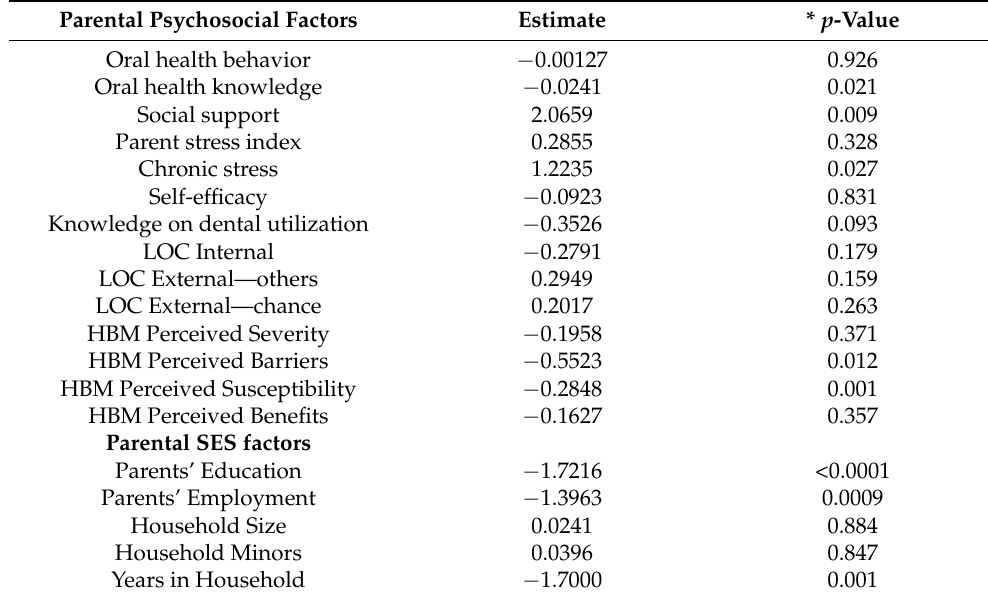
Table 2. Bivariate association between acculturation (less acculturated/more acculturated) and parental